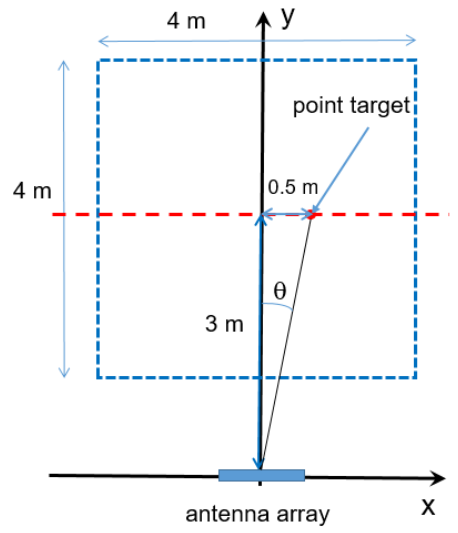
Figure 11. Geometry of the scenario: in the x–y plane. Point target and considered ROI (dashed blue line).